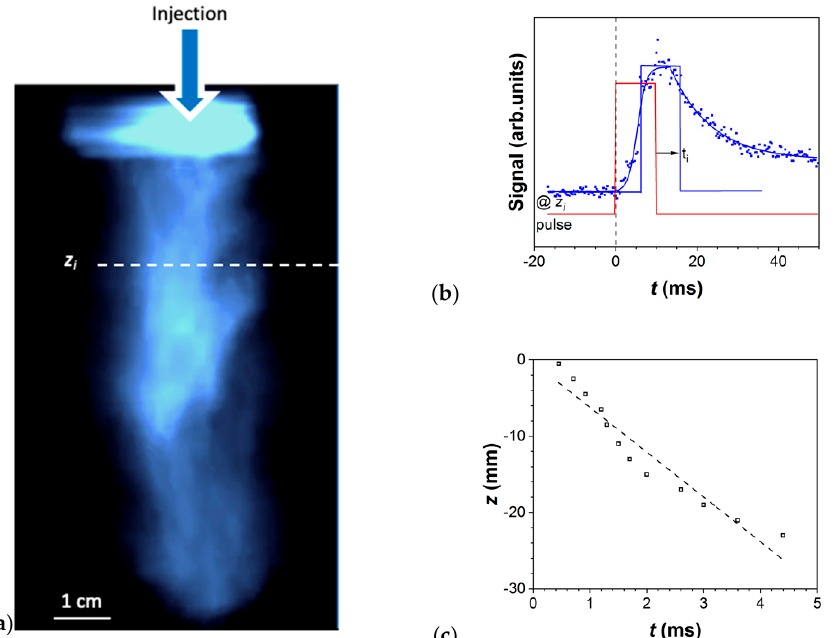
Figure 3. ( a ) Typical image of the aerosol formed with DLI (pentane, t liq = 5 ms, t gas = 10 ms, ∆ t = 2 ms, f = 1 Hz) obtained by fast imaging. ( b ) Temporal evolution of scattered light intensity. The delay t i between pulsed aerosol injection (red curve) and the variation of light intensity (blue one) obtained for different positions z i enables to determine ( c ) the droplet’s average velocity.